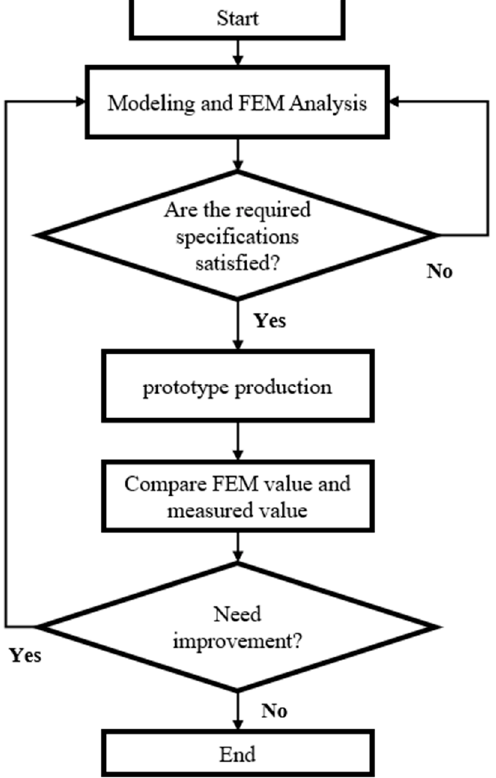
Figure 7. Flowchart for the development of one-coil long-stroke PMA.